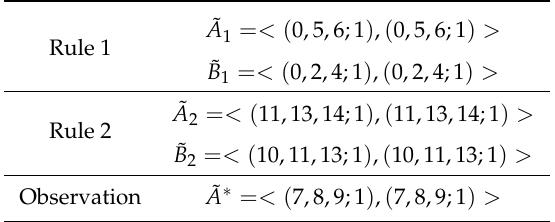
Table 4. Involved interval type-2 fuzzy sets for Case 4.